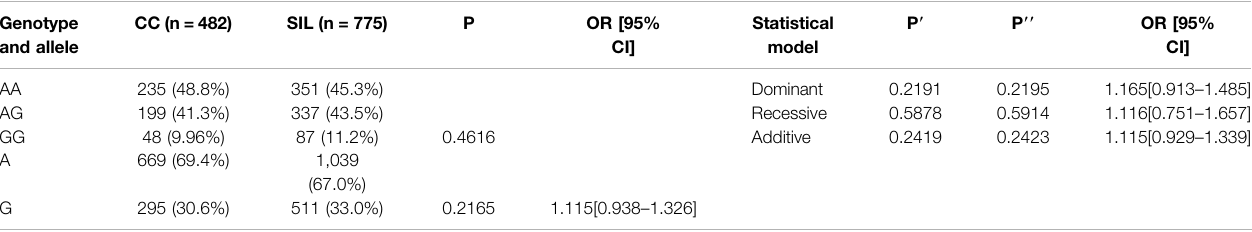
TABLE 4 | Comparison of genotypes and allele distribution frequencies between the CC group and the SIL group. Genotype and allele